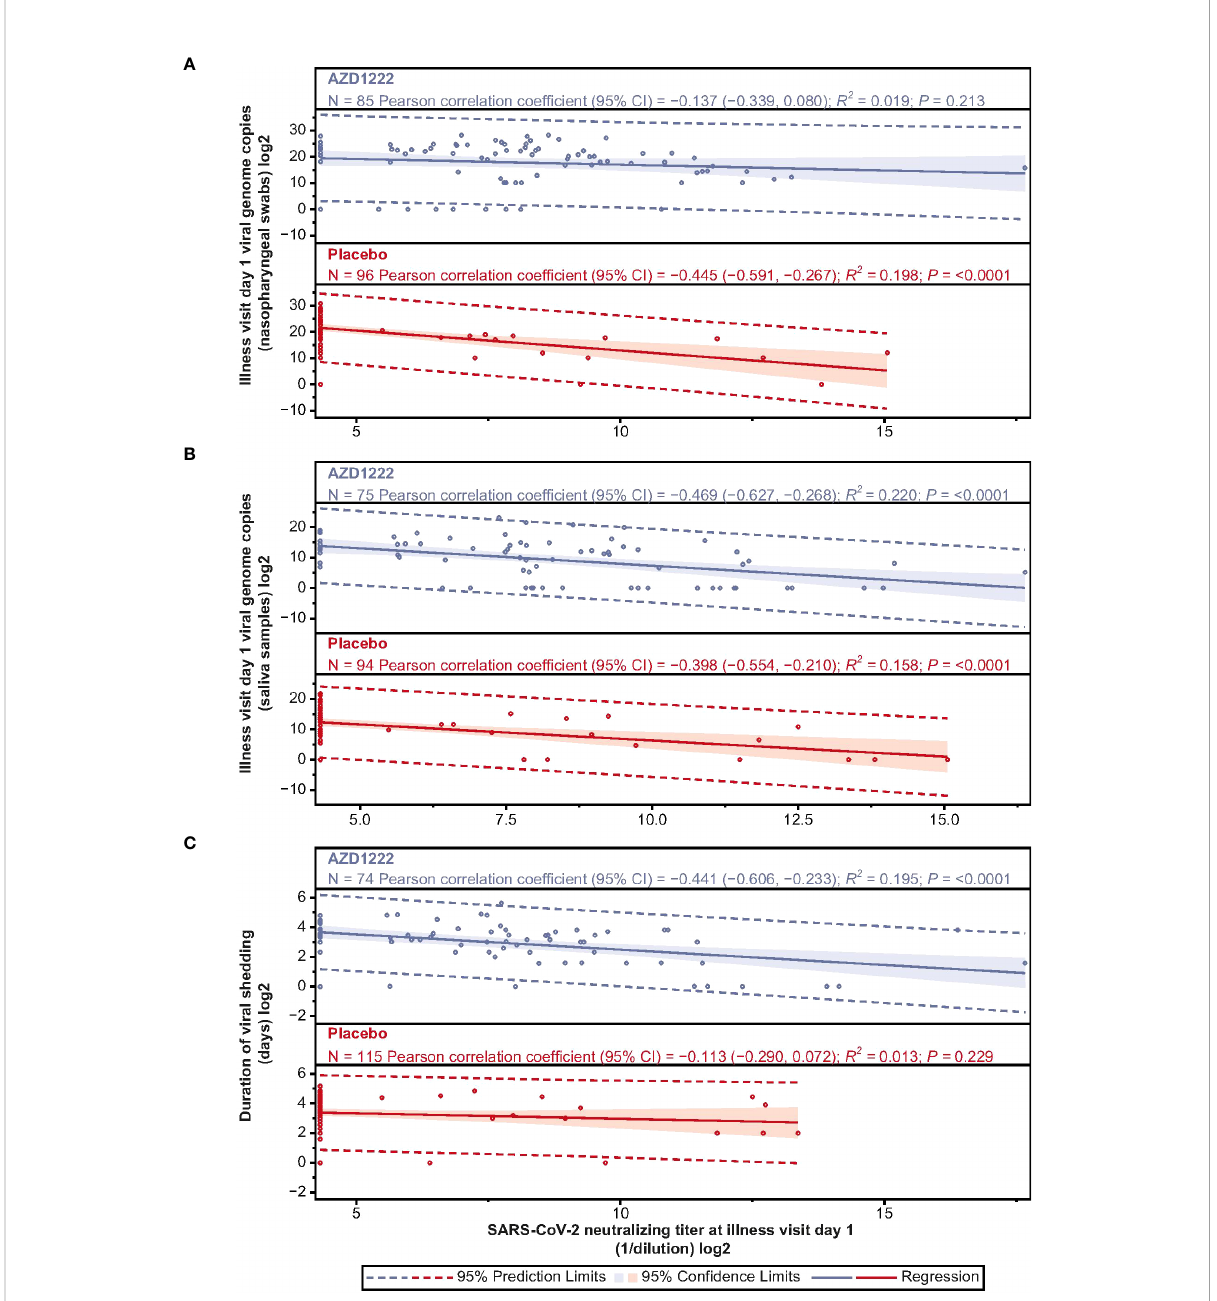
FIGURE 5 Illness visit day 1 SARS-CoV-2 nAb titers display low-moderate negative correlations with SARS-CoV-2 virologic outcomes. Scatterplot analysis depicting the relationship between (A) SARS-CoV-2 viral load in nasopharyngeal swabs (B) SARS-CoV-2 viral load in saliva samples, and (C) duration of viral shedding in saliva (y-axes) and illness visit day 1 nAb titers (x-axes) in vaccinees and placebo recipients. Blue and red shading denotes 95% CI. Dotted line denotes 95% prediction limits. Clustering of participants along the y-axis occurs due to levels of serum anti-SARS- CoV-2 neutralizing antibody falling below the assay lower limit of quanti fi cation (LLOQ). LLOQ= 40 ID50. 50% of LLOQ =20